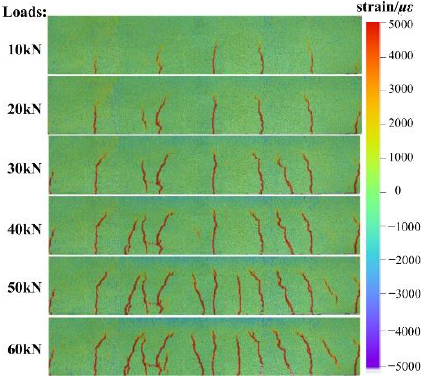
Figure 14. Crack propagation on beam surface under different loads.